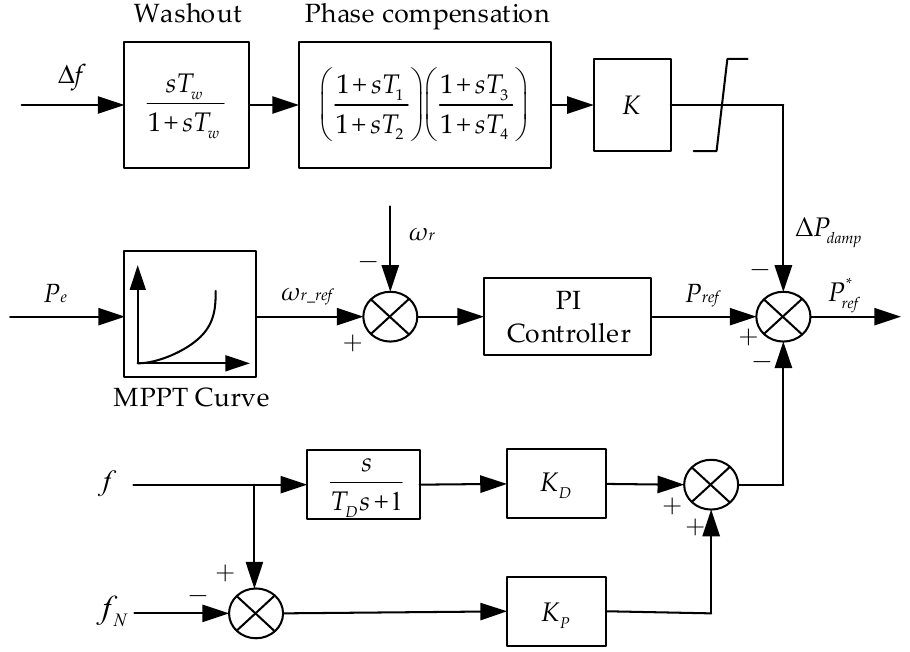
Figure 8. IC strategy of DFIG-based WT considering low frequency oscillation suppression. In the proposed improved IC strategy, the control link of the IC is the same as that of the IC adopted in the previous section. In order to suppress the LFO, a damping control link is introduced. At present, the selections of the feedback signal for damping control of DFIG-based WTs are usually frequency, rotor speed difference between synchronous gen- erators, output active power deviation of DFIG-based WTs, etc. [15,16,21–24]. In this pa- per, the control feedback signal is selected as the frequency deviation of the system with- out adding other signals. In the damping control link, the washout block is a high-pass filter, whose function is to block the steady-state input signals, so that the LFO suppres- sion module does not work when the system is in steady-state operation [34]. The phase compensation block is composed of two lead/lag blocks to compensate for the phase lag between the input frequency deviation and the generator electrical torque [24,29]. K is the gain of the damping control link, and a saturation block is added after the gain K to ensure that the active power output after the control link is limited within the capacity of the inverter.